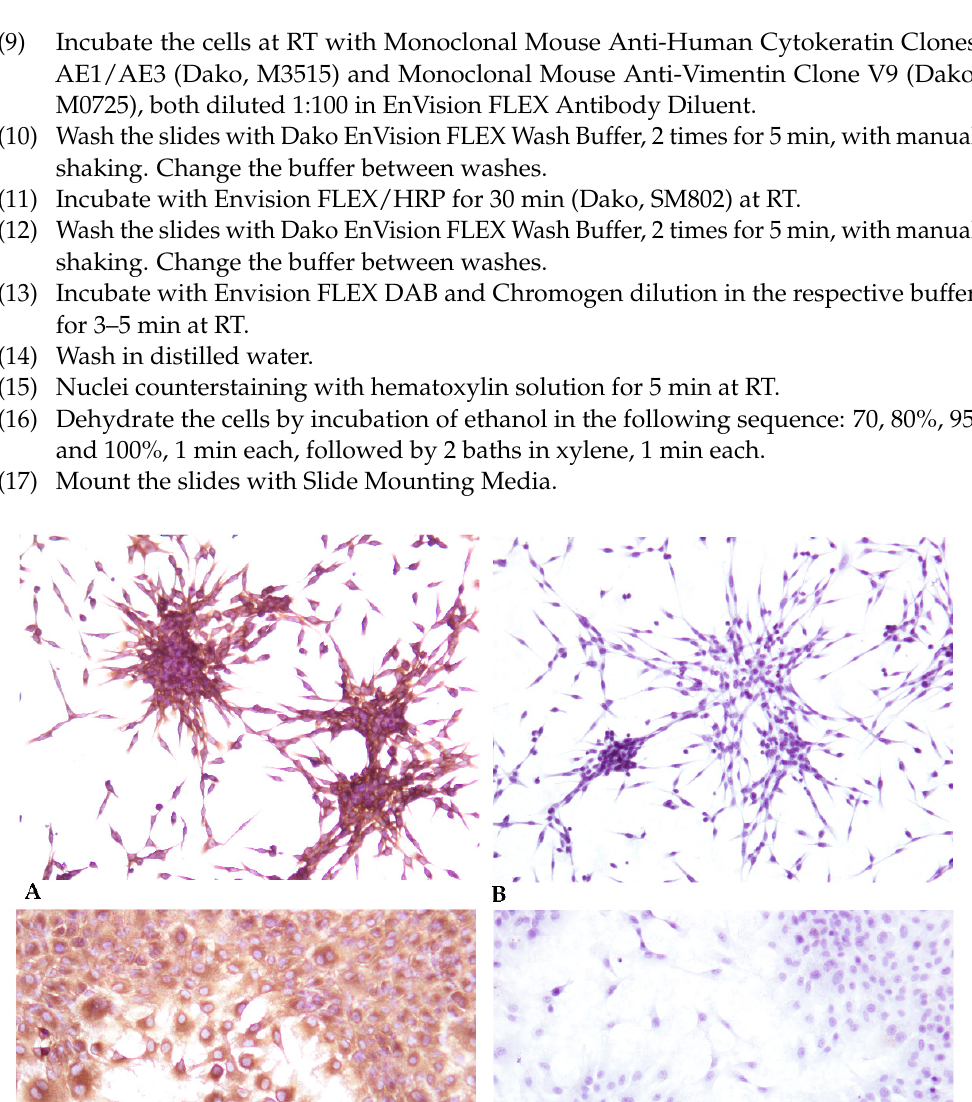
Incubate the cells at RT with Monoclonal Mouse Anti-Human Cytokeratin Clones AE1/AE3 (Dako, M3515) and Monoclonal Mouse Anti-Vimentin Clone V9 (Dako, M0725), both diluted 1:100 in EnVision FLEX Antibody Diluent.